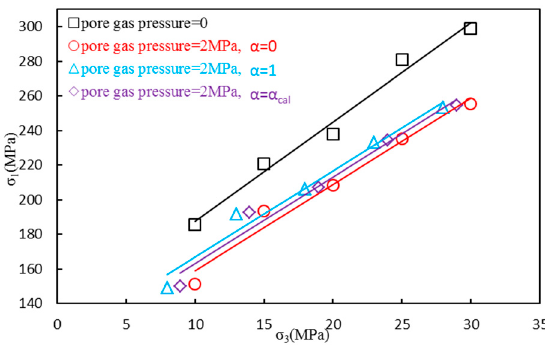
Figure 9. Measured strength data and curves fitted using the Mohr-Coulomb criterion.